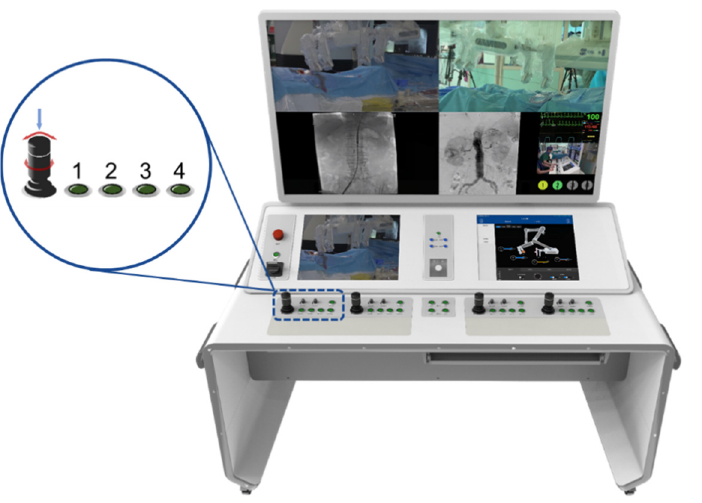
Figure 1. An overview of the interventional console and the model of the joystick in the interventional console. The upper part of the joystick is a button and can be pressed to control the loosening and clamping of manipulators. The lower part of the joystick is a knob and can be rotated to control the rotation of manipulators. Left and right swing of the joystick can control the advancement and retraction of manipulators. Control of manipulators can be chosen by pressing different green selection buttons (one bottom refer to one manipulator).